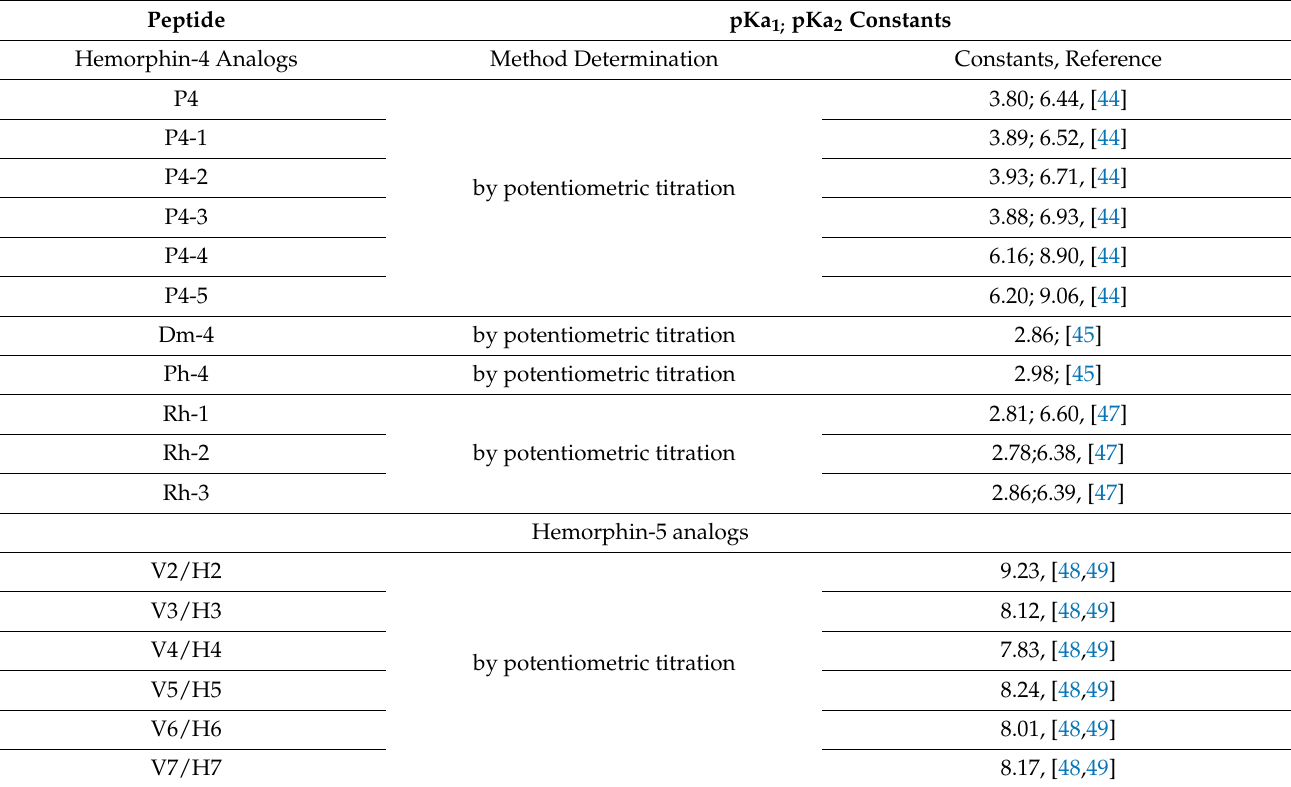
Figure 6. Summary plot of isoelectric point (pI) values of hemorphin analogs. Table 6. Parameters of the voltammetric measurements and the electrochemical data of